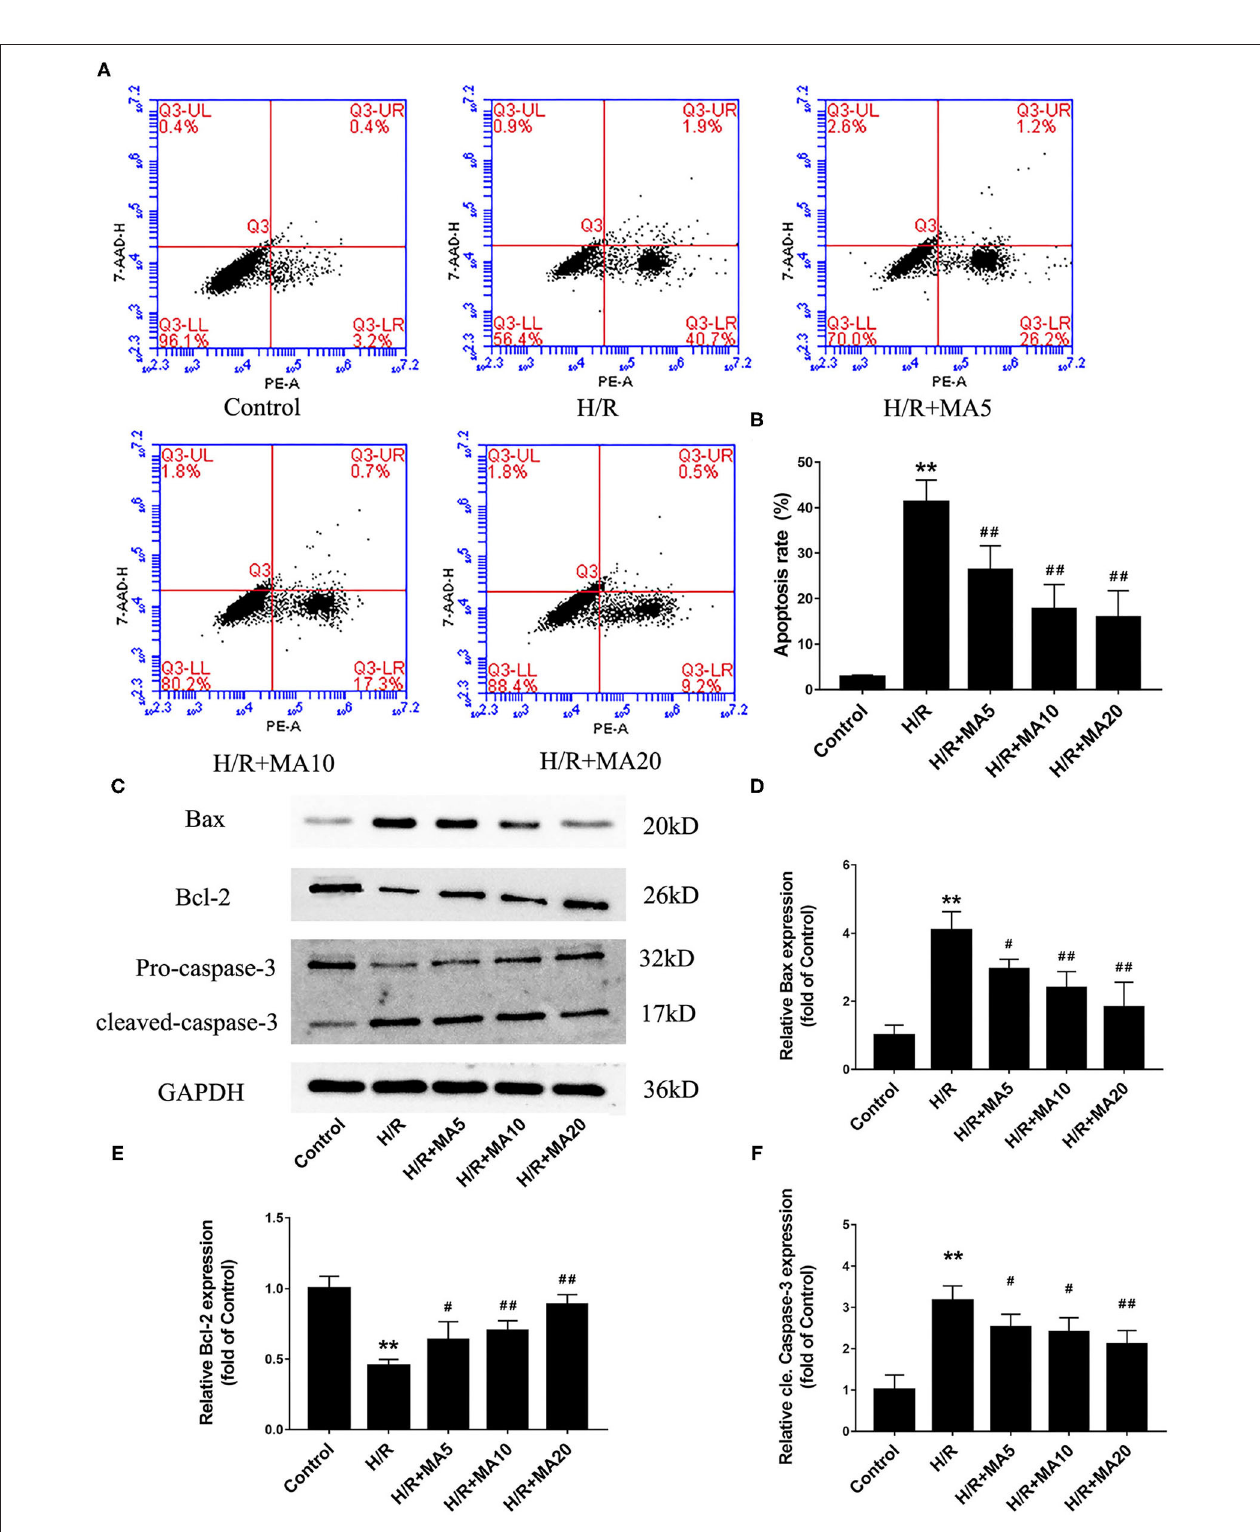
FIGURE 2 | The effects of MA on cardiomyocyte apoptosis and the expression of apoptosis-related proteins after H/R treatment. (A,B) After various treatments, the apoptosis is measured by Annexin V-PE/7-AAD using flow cytometry and the results are expressed in bar graphs. (C) Western blot was performed to assess the expression of apoptosis-related proteins (Bax, Bcl-2, and cleaved caspase-3) in H9c2 cell under H/R conditions. (D–F) The quantitative analysis of apoptosis-related proteins is shown in bar graphs. All the values are representative of at least three independent experiments and expressed as the mean ± SD. ** P < 0.01 vs. control group; # P < 0.05 and ## P < 0.01 vs. H/R